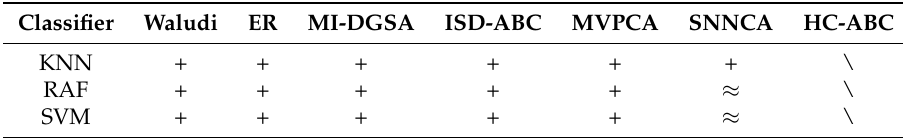
Table 4. The results of t-test on the seven